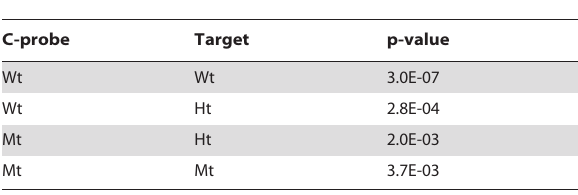
Table 4. Comparison of Rts among days.